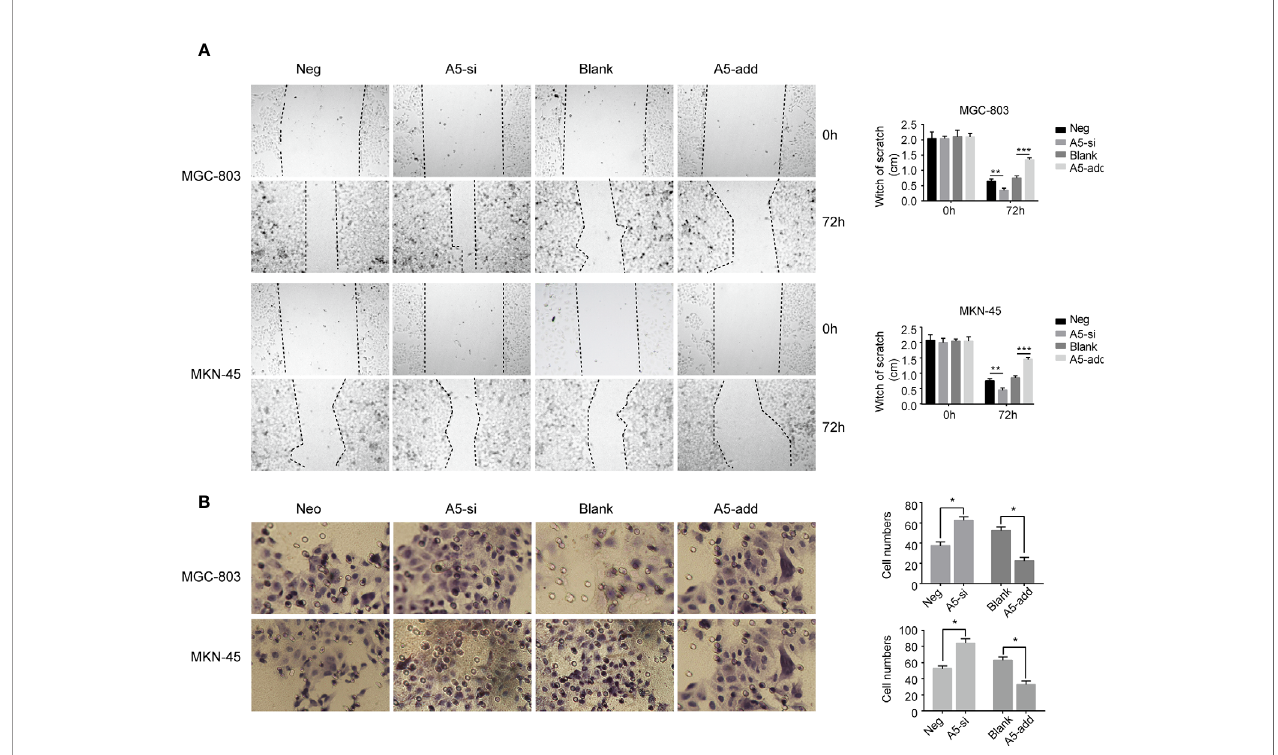
FIGURE 4 | ANXA5 regulated gastric cancer cell metastasis. Wound healing assay was applied to detect the migration of the cells. The si-ANXA5 cells migrated fast while the A5-add group cells showed reduced migration ability ( P < 0.0001) (A) . transwell assay was used to detect the cells ’ invasion ability; A5-si cells have an obviously increased quantity, and A5-add cells have an decreased quantity (B) . * P < 0.05, ** P < 0.01, *** P <